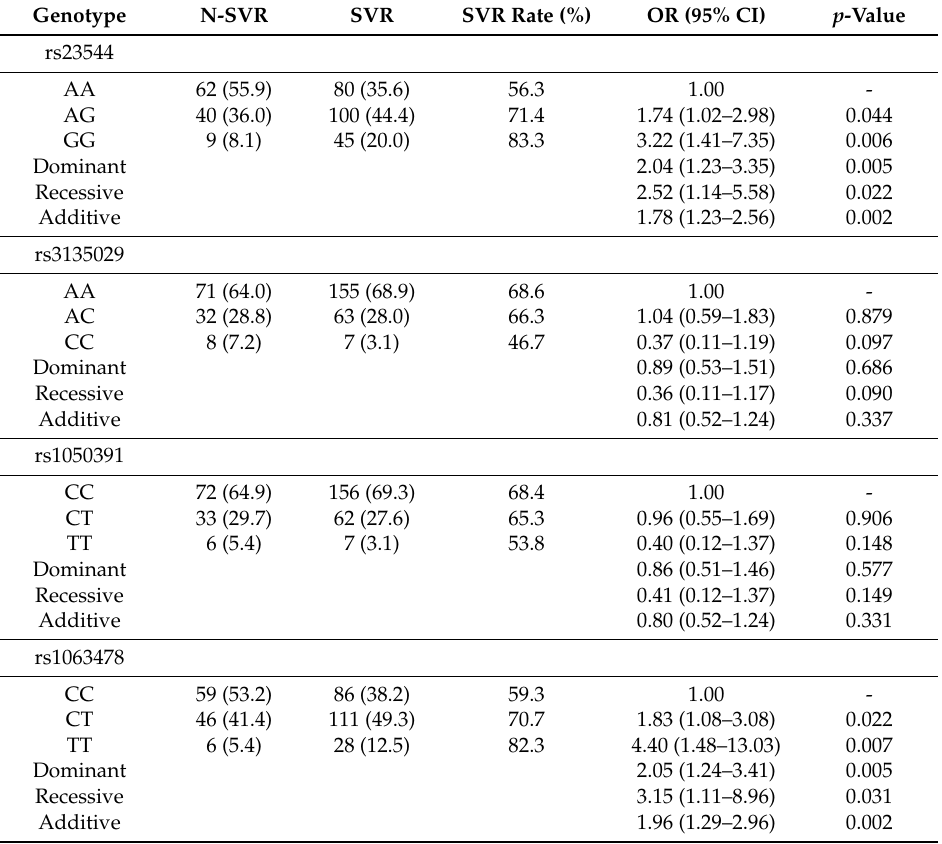
Table 2. Association of SNPs in HLA-DM with